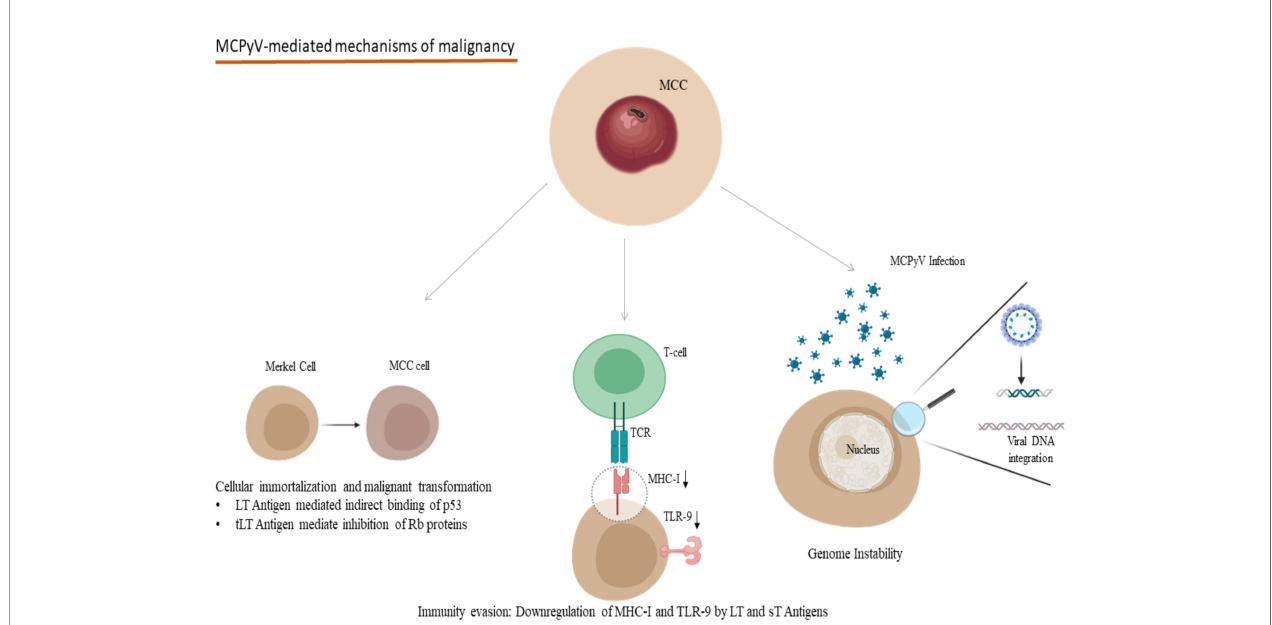
FIGURE 2 | Oncogenic mechanisms in the development of MCPyV-related MCC: Indirect binding of p53 and inhibition of Rb proteins due to LT and tLT antigens of MCPyV lead to cellular immortalization and malignant transformation. LT and sT antigens contribute to the evasion of the immune system mechanisms by downregulating MHC-I and TLR-9. Viral DNA integration to the host genome participates in genome instability. (MCPyV, Merkel Cell Polyomavirus; MCC, Merkel Cell Carcinoma; LT, Large T; tLT, truncated Large T; sT, small T, MHC-I, Major Histocompatibility Complex Class I; TLR-9, Toll-like receptor 9; TCR, T-cell receptor). Created in